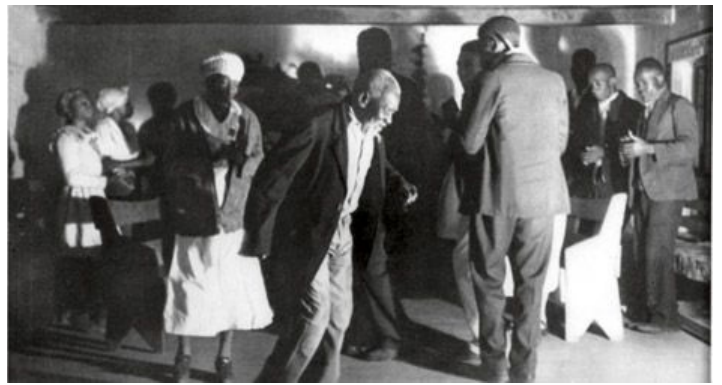
Figure 2. Ring Shout in Georgia, circa 1930. Image courtesy of Lorenzo Dow Turner Papers,